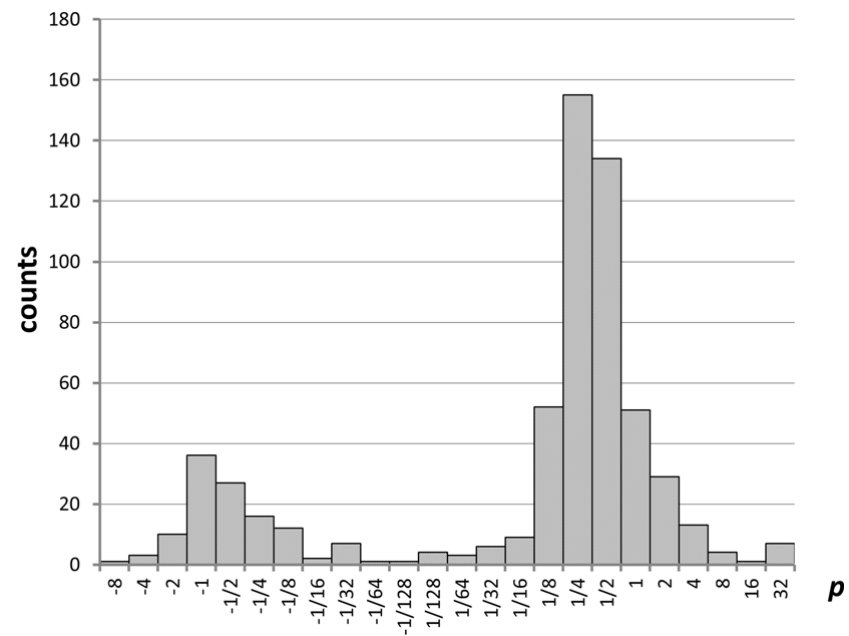
Figure 6. Distribution of optimal values of the Box–Cox transformation parameter p obtained in a 1,000-trials run. Intervals on the horizontal axis are logarithmically equal, except for the interval encompassing the zero value. The vertical axis is the number of transitions with p close to the value below the horizontal axis (see